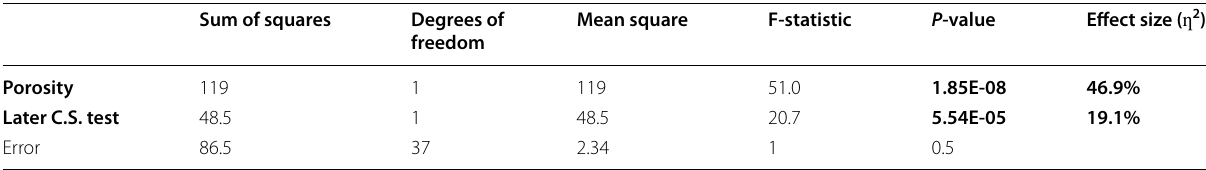
Table 3 ANOVA to explain changes in compressive strength among NaHCO compressive strength test performance